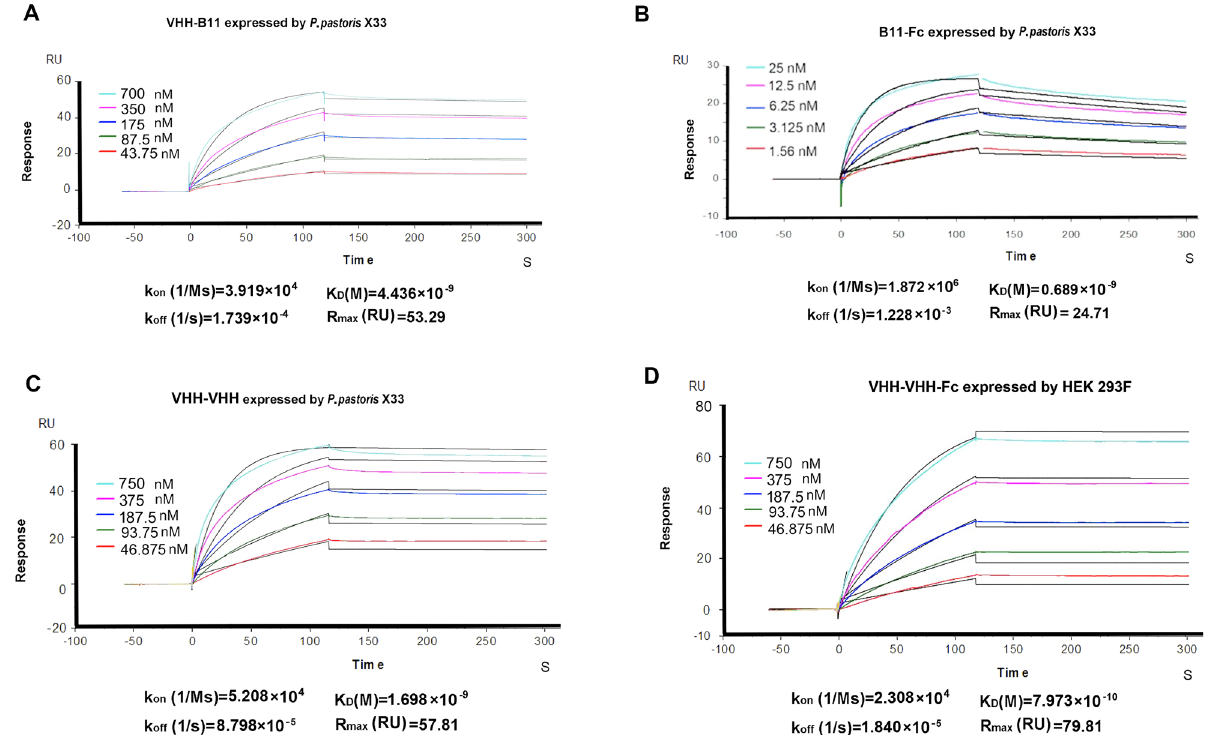
Figure 2. Affinity tests between the VHH-B11 or its derived antibodies and human PCSK9. The affinity was determined by SPR technology. Taking VHH-B11 for example, two-fold dilution of the VHH-B11 Ab (five concentrations in nM) expressed by P. pastoris X33 were loaded to bind the hPCSK9 coated on the CM5 chip. Each colored line represents a on concentration (in nM) of the VHH-B11 Ab. The black line was the automatic fitting curve by the built-in evaluation software of Biacore T200. The horizontal axis represents the injection time, and the vertical axis represents the response unit (RU) value of the VHH-B11 interaction with hPCSK9. The VHH-B11 injection time point was set as 0 s by the evaluation software. ( A ) VHH-B11; ( B ) VHH-B11-Fc; ( C ) VHH-VHH; ( D )